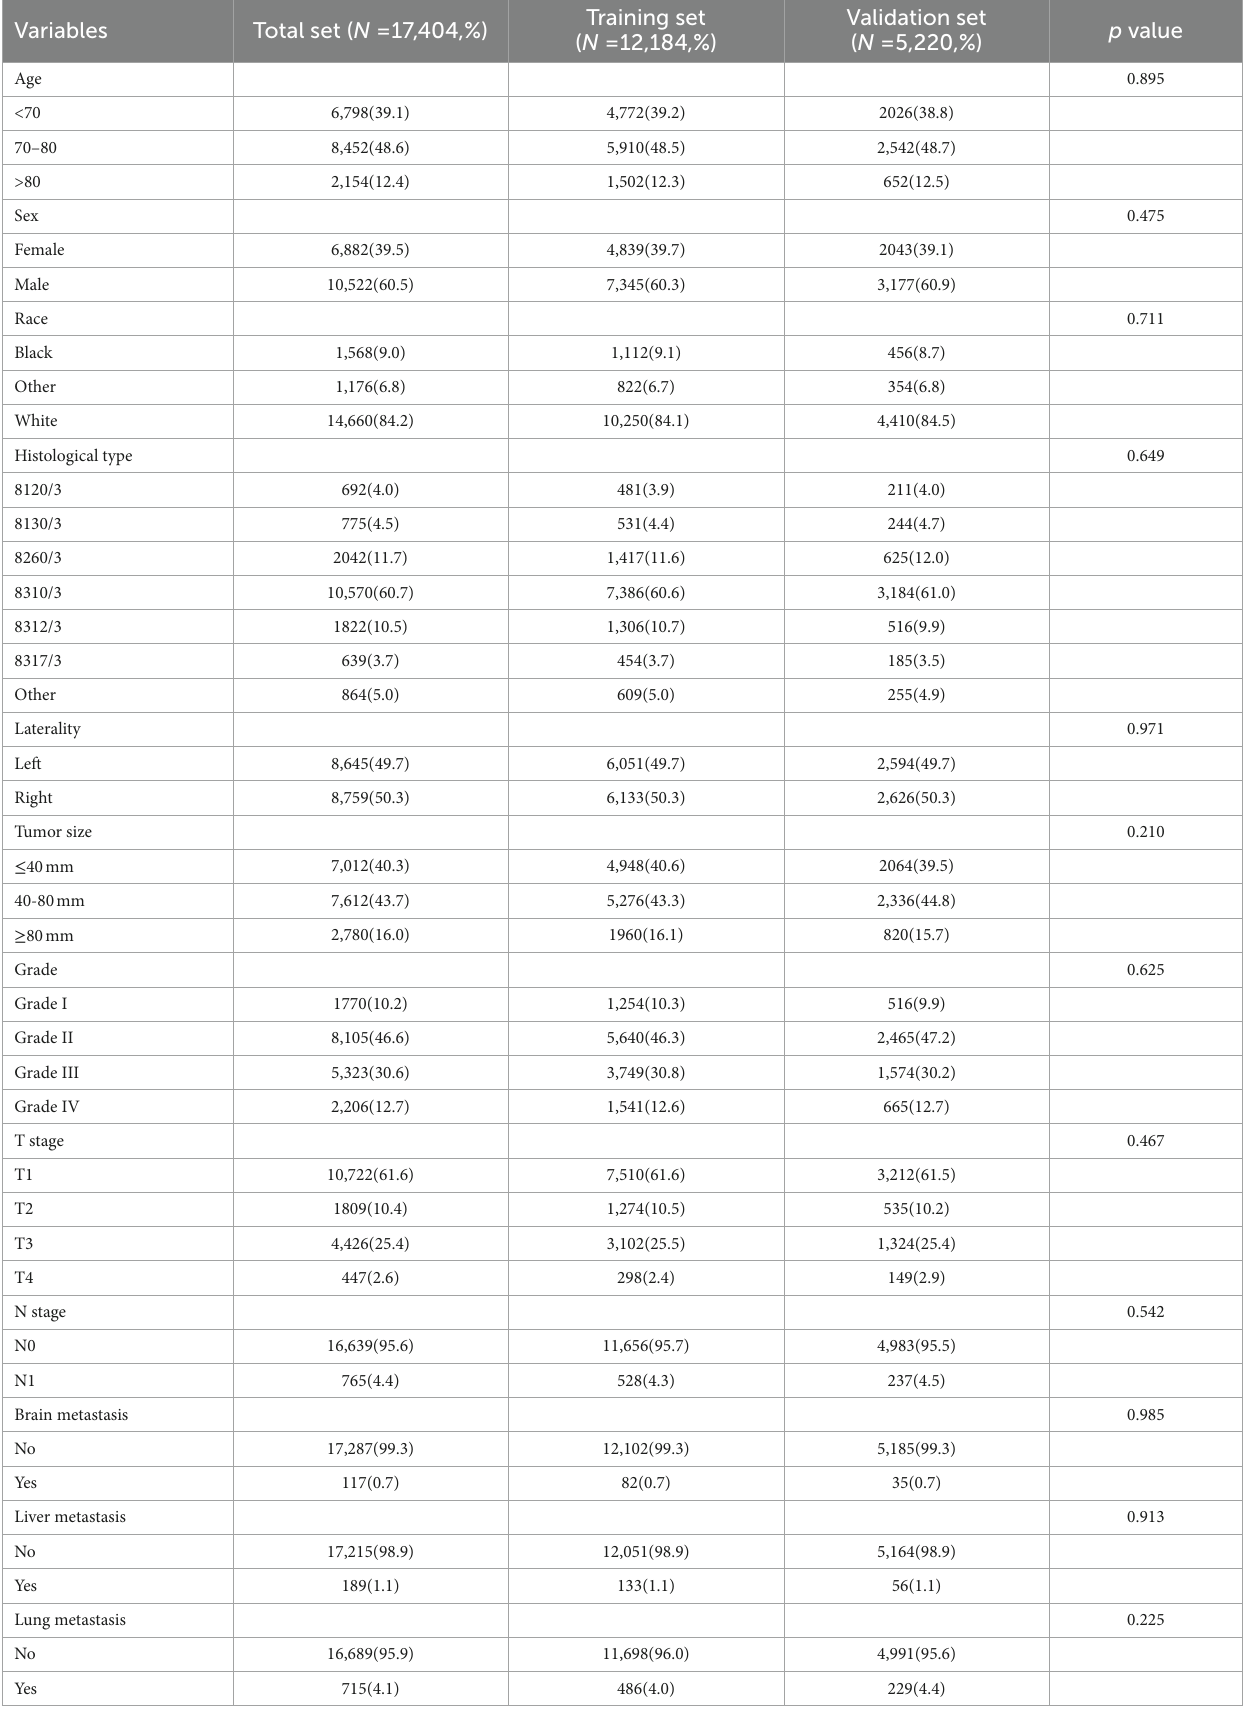
TABLE 1 The demographic and clinicopathological characteristics of the elderly kidney cancer (KC) patients with or without bone metastases (BM).